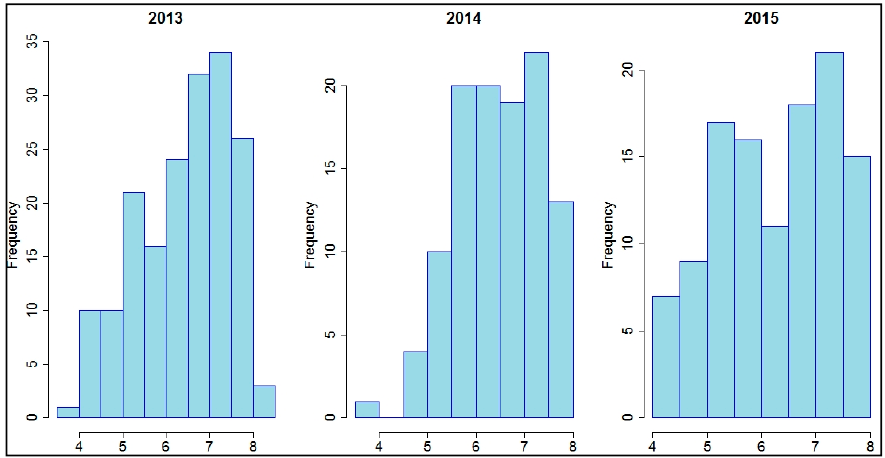
Figure 5. Frequency distributions of soil pH for each year.